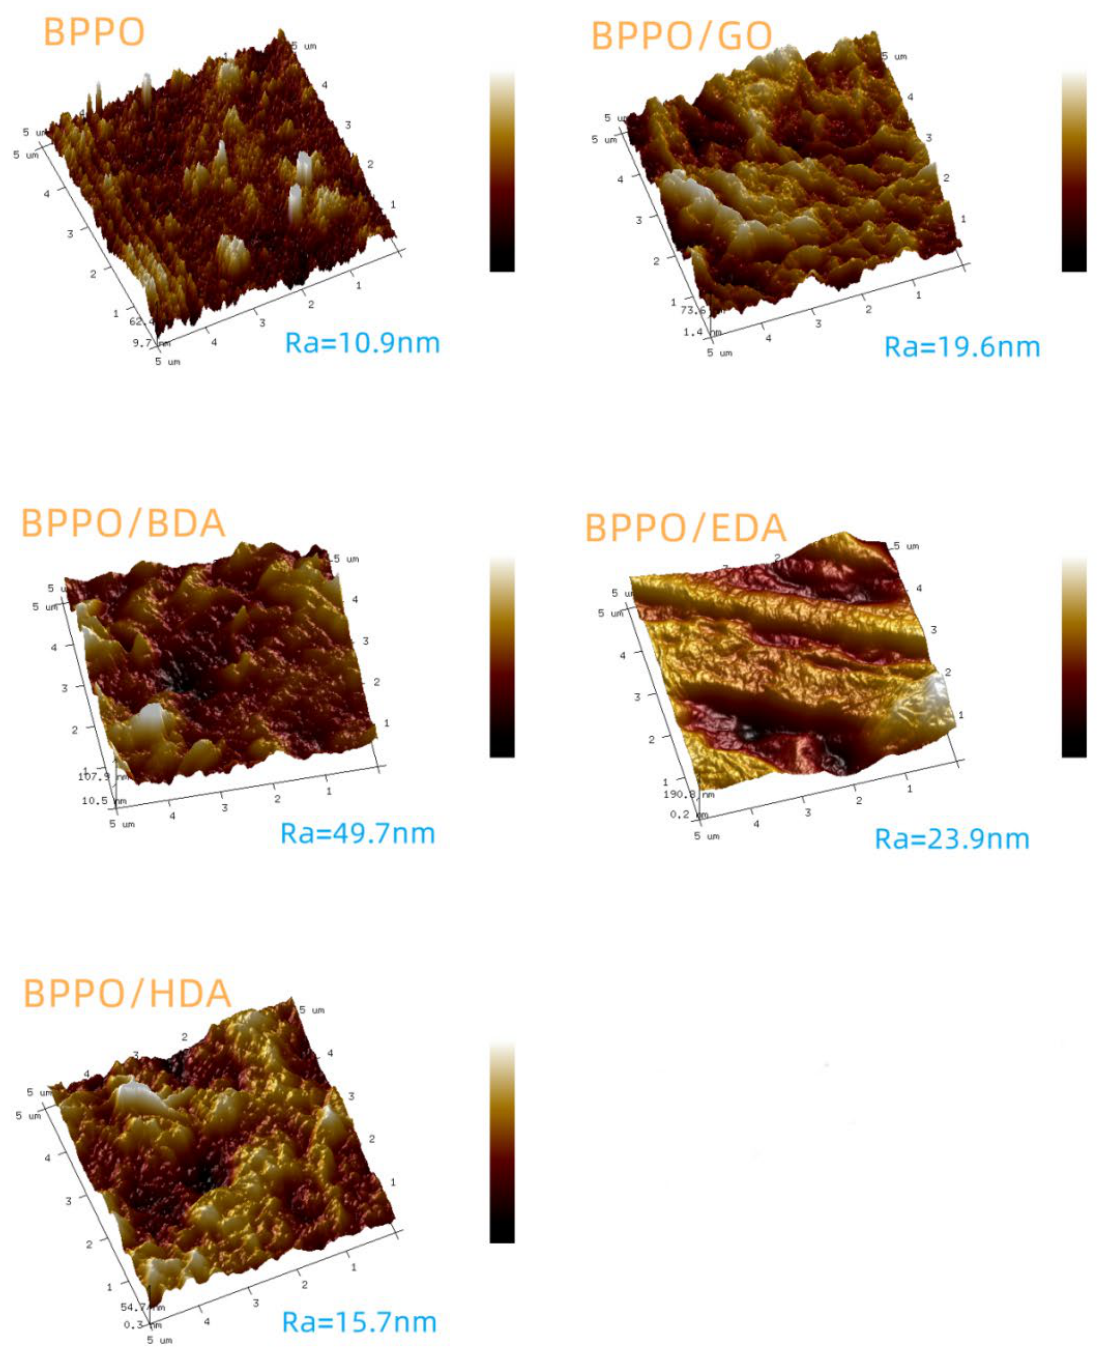
Figure 2. AFM images of the BPPO membrane, BPPO/GO membrane, and Ax-GO-modified nanofiltration membranes.